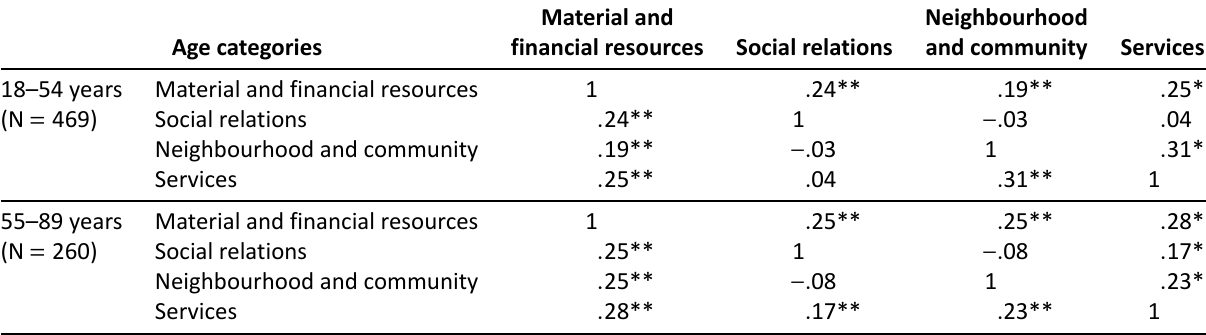
Table 3. Correlation between dimensions of social exclusion (summative